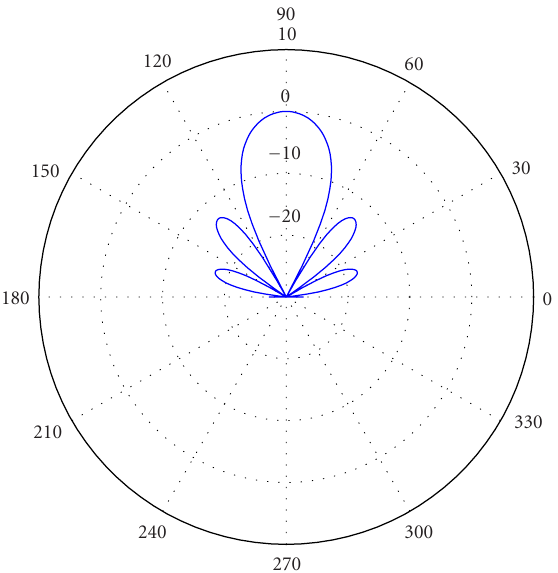
Figure 10: Radiation pattern response for microstrip antennas at 60 GHz, adapted from [15] with a sinc function of order